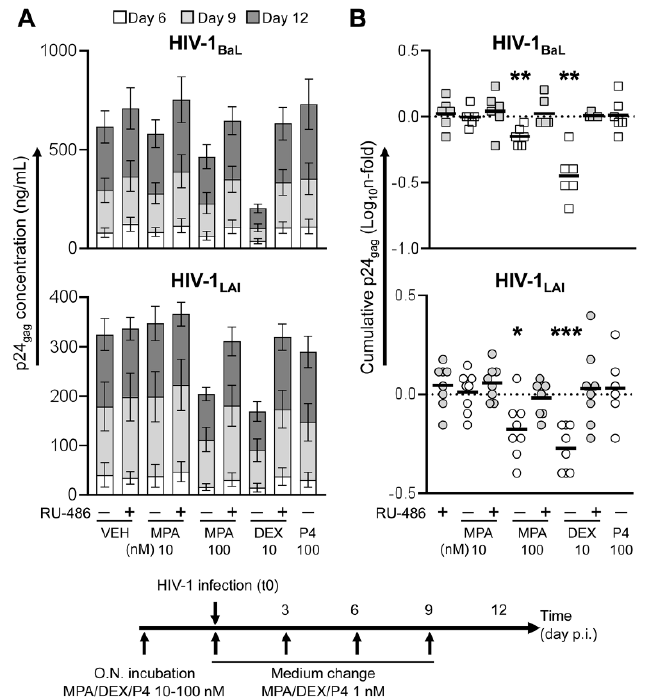
Figure 1. Virus production in tonsillar tissue explants treated with steroid hormones prior to HIV-1 infection (pre-infection). Tissue explants were incubated with medroxyprogesterone acetate (MPA), dexamethasone (DEX) and progesterone (P4) at the indicated concentrations, in the presence or the absence of mifepristone (RU-486) at 1 µ M, overnight upon dissection. Culture supernatant was replaced with fresh medium containing MPA, DEX or P4 at 1 nM, in the presence or the absence of RU-486 at 1 µ M, immediately before infection with HIV-1 BaL (top, n = 6) and HIV-1 LAI (bottom, n = 6–8). Explants were cultured using the same medium composition for 12 days with a change of medium every 3 days. ( A ) Kinetics of HIV-1 infection measured as the amount of p24 gag released in culture supernatant over time. Bars indicate mean values with s.e.m. ( B ) N-fold change in cumulative virus production (Day 6 to Day 12 post-infection) in supernatant of treated explants compared to donor-matched untreated explants (VEH). Lines indicate mean values. Asterisks denote a statistically significant difference with VEH (one sample t test,* p < 0.05, ** p < 0.01, *** p < 0.001).